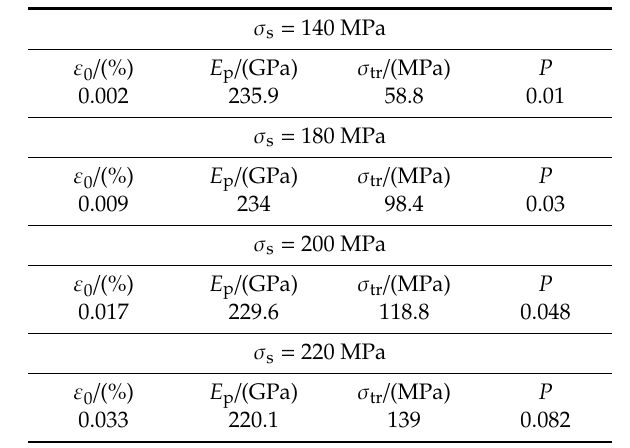
Figure 14. ( a ) The tensile stress–strain curves; ( b ) the tangent modulus versus strain curves; ( c ) the interface debonding fraction versus stress curves; and ( d ) the broken fibers fraction versus stress curves of UD SiC / SiC composite for conditions without stochastic loading and with stochastic loading of σ s = 140, 180, 200 and 220 MPa. Table 7. The tensile stress–strain curve, tangent modulus, interface debonding fraction and broken fiber fraction of unidirectional SiC / SiC composite subjected to stochastic loading of σ s = 140, 180, 200 and 220 MPa.